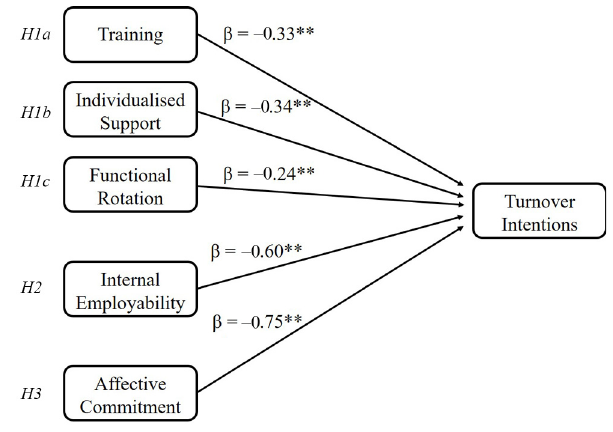
Figure 2. Association between variables ( H1 , H2